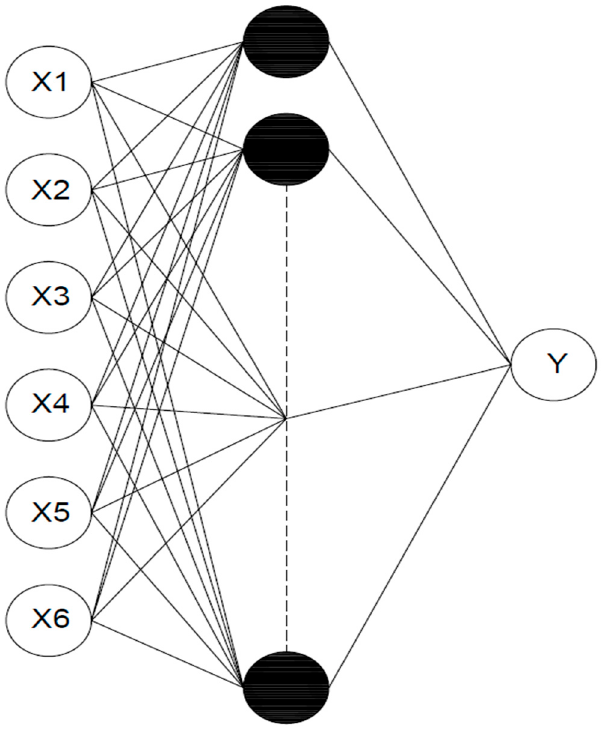
Figure 6. Architecture of the ANN model.